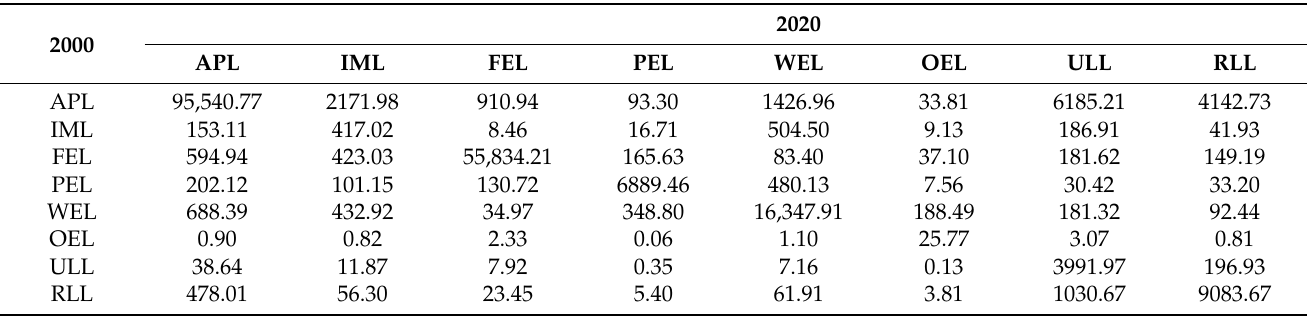
Table 3. Transformation matrix of land use in the YRDUA during 2000–2020 (km 2 ).